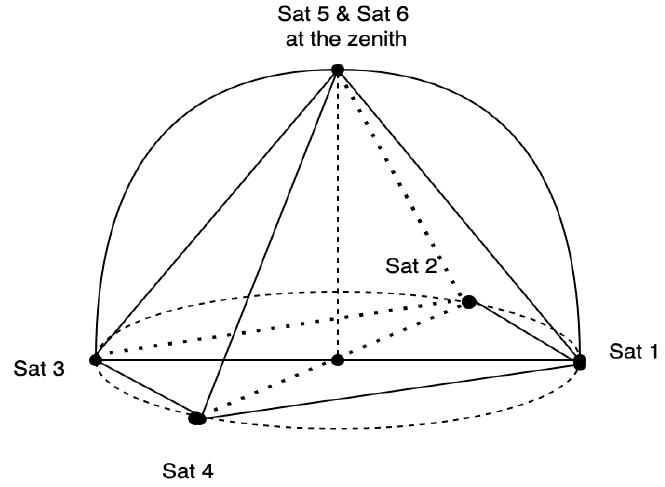
Figure 2. Layout of the six satellites with the smallest GDOP value.